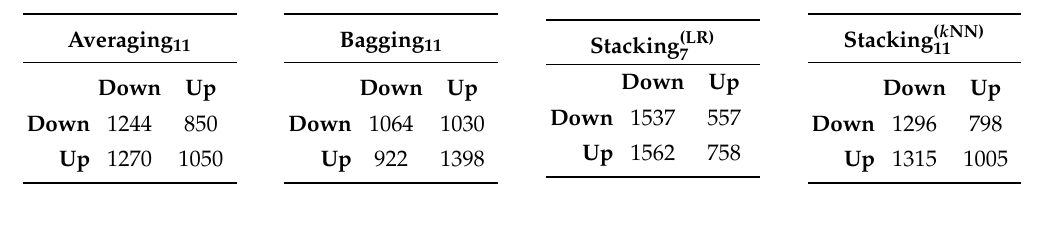
Table 8. Confusion matrices of Averaging 11 , Bagging 11 , Stacking (LR)